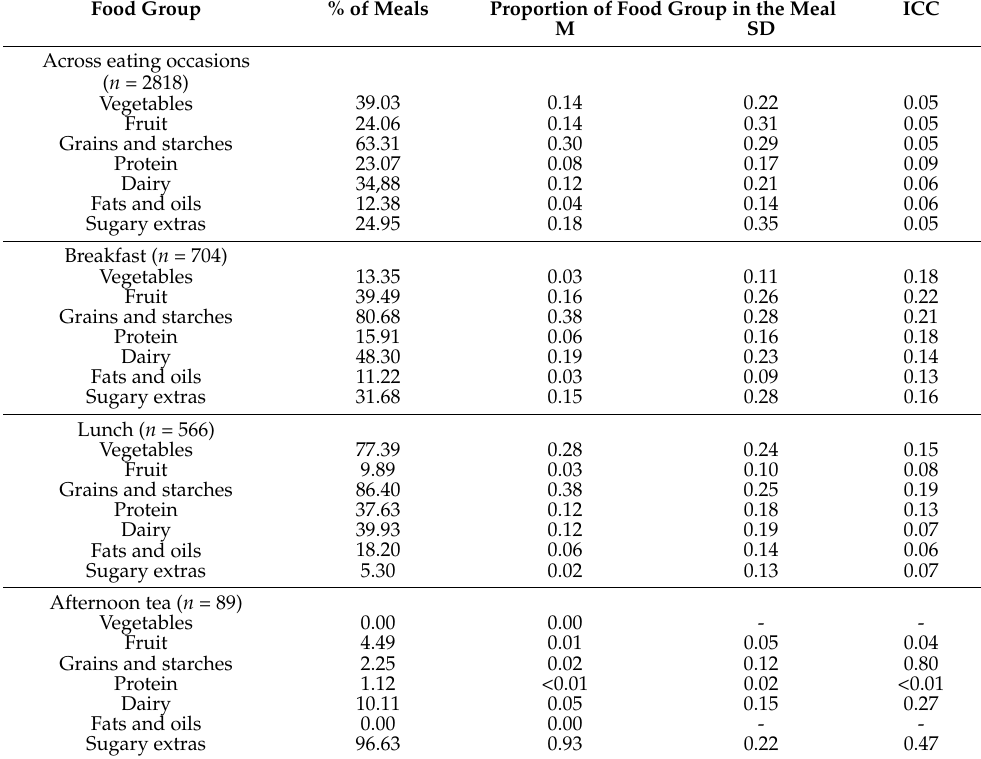
Table 2. Descriptive statistics for food groups consumed overall and per meal